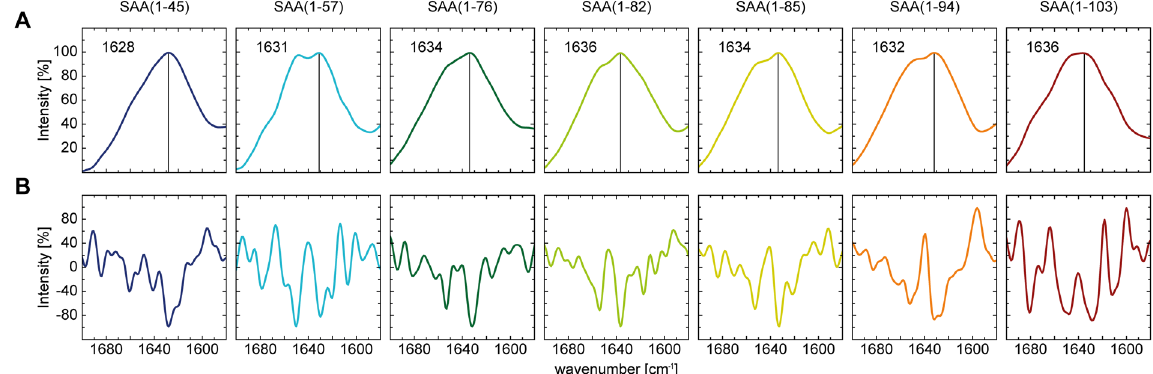
Figure 4. Secondary structure analysis of fibrils formed in vitro from SAA(1–103) and AA proteins. ( A ) ATR- FTIR spectra of preformed fibrils with indicated amide I maxima. ( B ) Second derivatives of the ATR-FTIR spectra, which were used to determine the positions of the secondary structural elements for the curve fitting procedure.